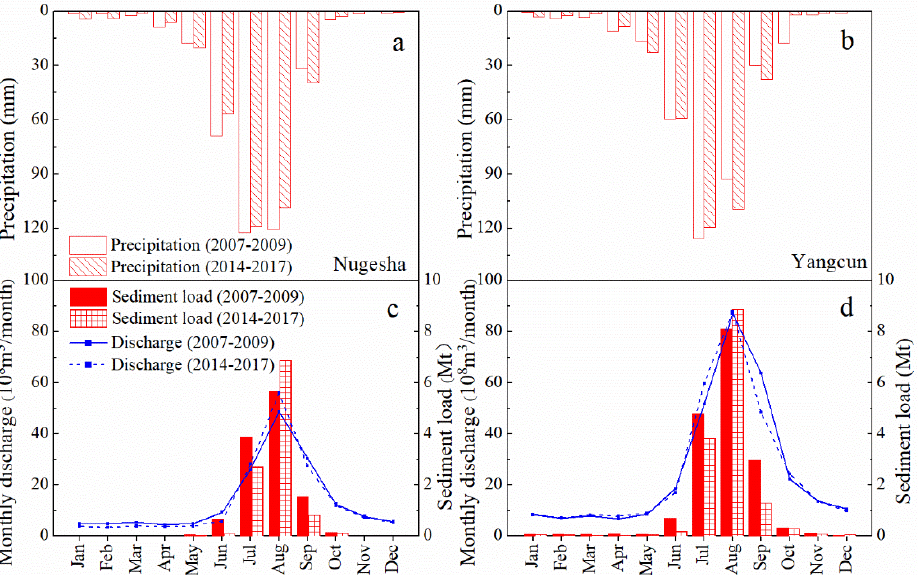
Figure 3. Monthly precipitation, discharge and sediment loads at the Nugesha and Yangcun Stations in the periods of 2007–2009 and 2014–2017; panels ( a , b ) show the monthly precipitation at Nugesha and Yangcun Stations, respectively; panels ( c , d ) show the monthly discharge and sediment load at Nugesha and Yangcun Stations, respectively.